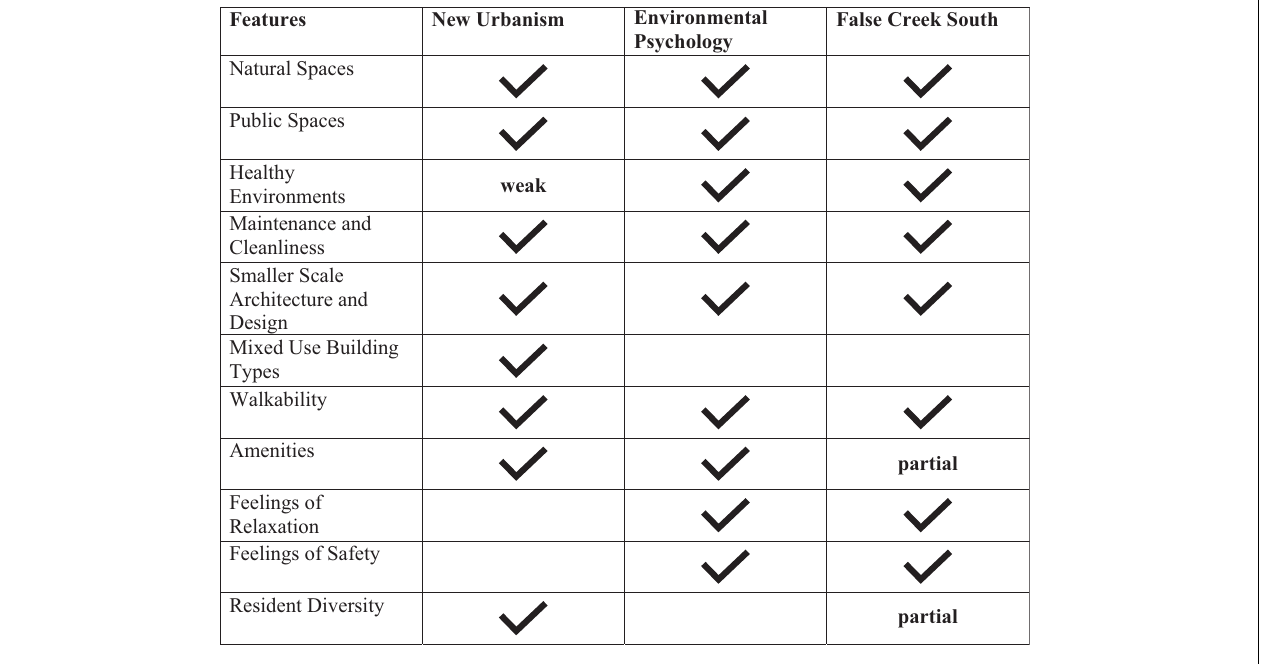
brownfield redevelopment with their legacies of toxic